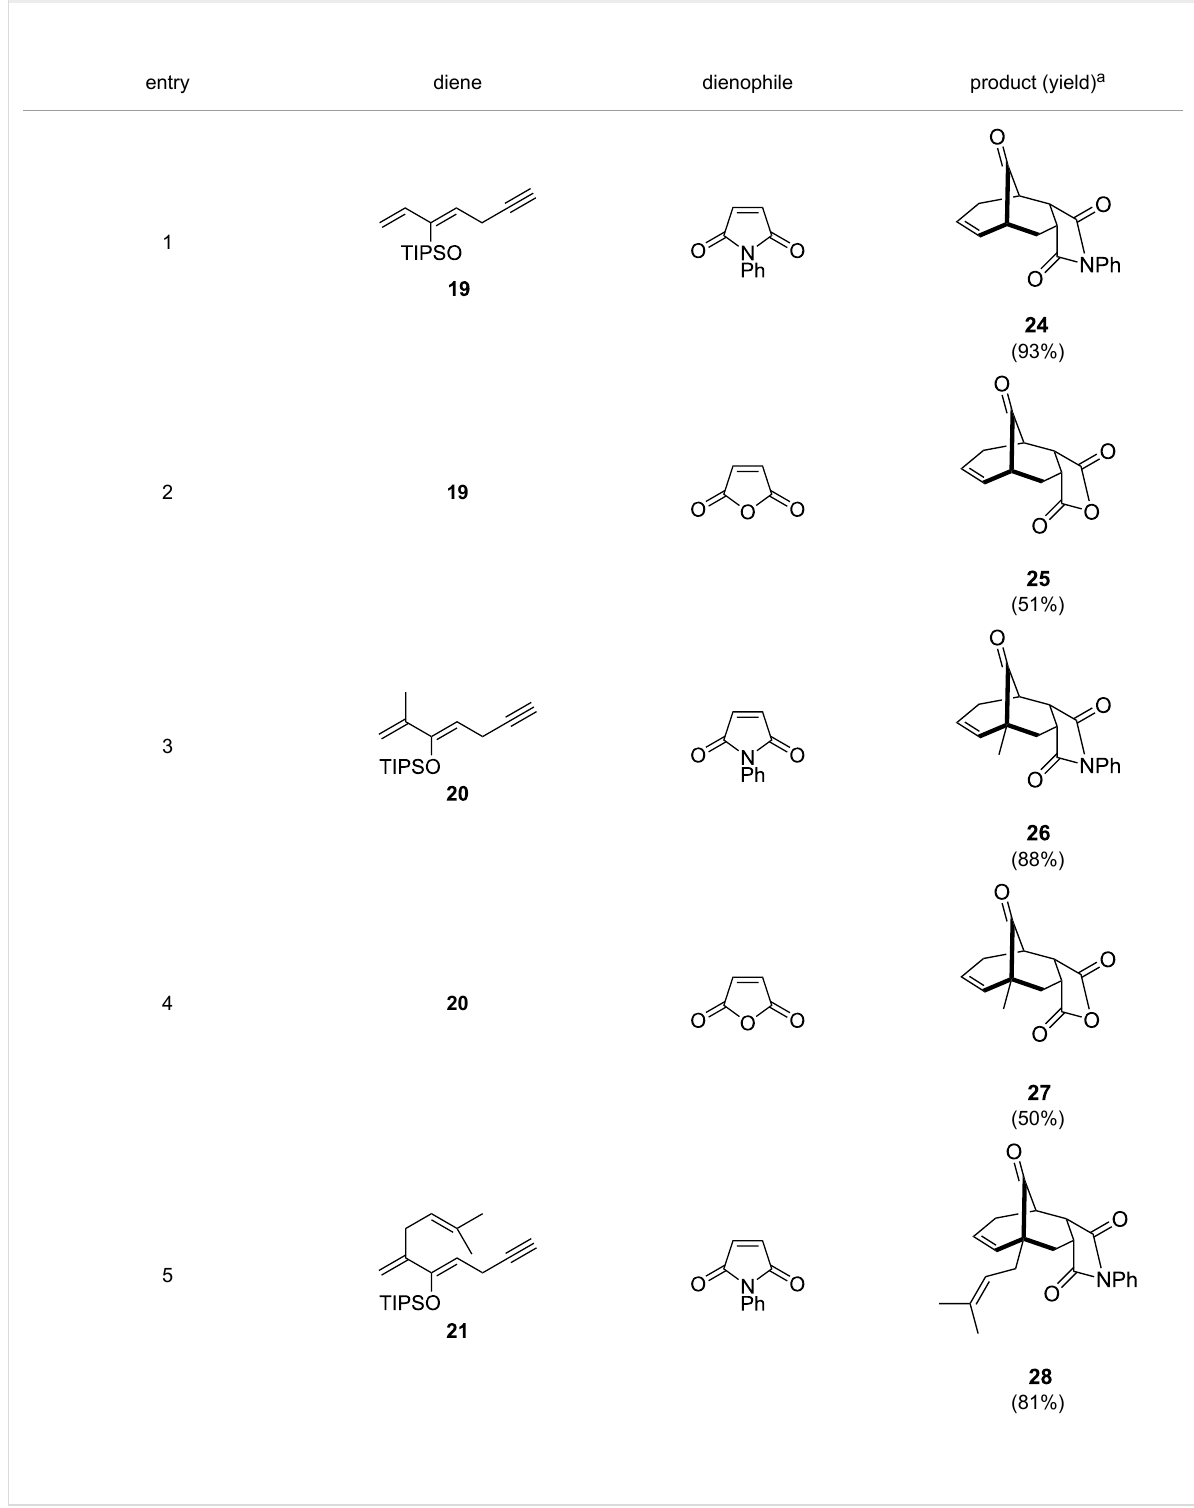
Table 1: Results of the one-pot Diels–Alder reaction/Au(I)-catalyzed